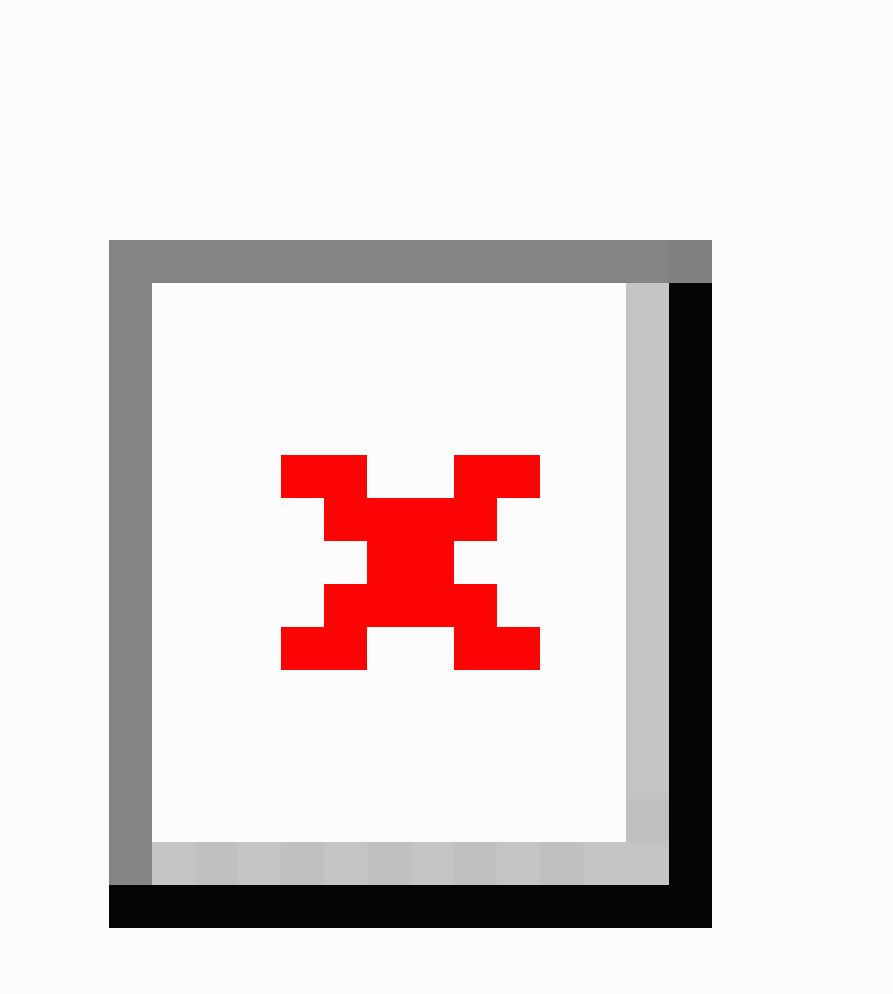
Figure 2. The mediation model and standardized path coefficients. Results of multigroup analysis and path coefficients across the 2 gamer types, multiplayer online first-person shooter (MOFPS) and massively multiplayer online role-playing games (MMORPGs), and the explained variance of the endogen variables ( R 2 ) (MOFPS: n=872; MMORPG: n=1466). The first (left) values describe MOFPS players, whereas the second (right) values describe MMORPG players. All 7 mediator variables are latent variables. For clarity, indicator variables associated with them have not been depicted figure. Simple arrows: significant path coefficients; dotted arrows: nonsignificant path coefficients. * P <.05; ** P <.01; *** P